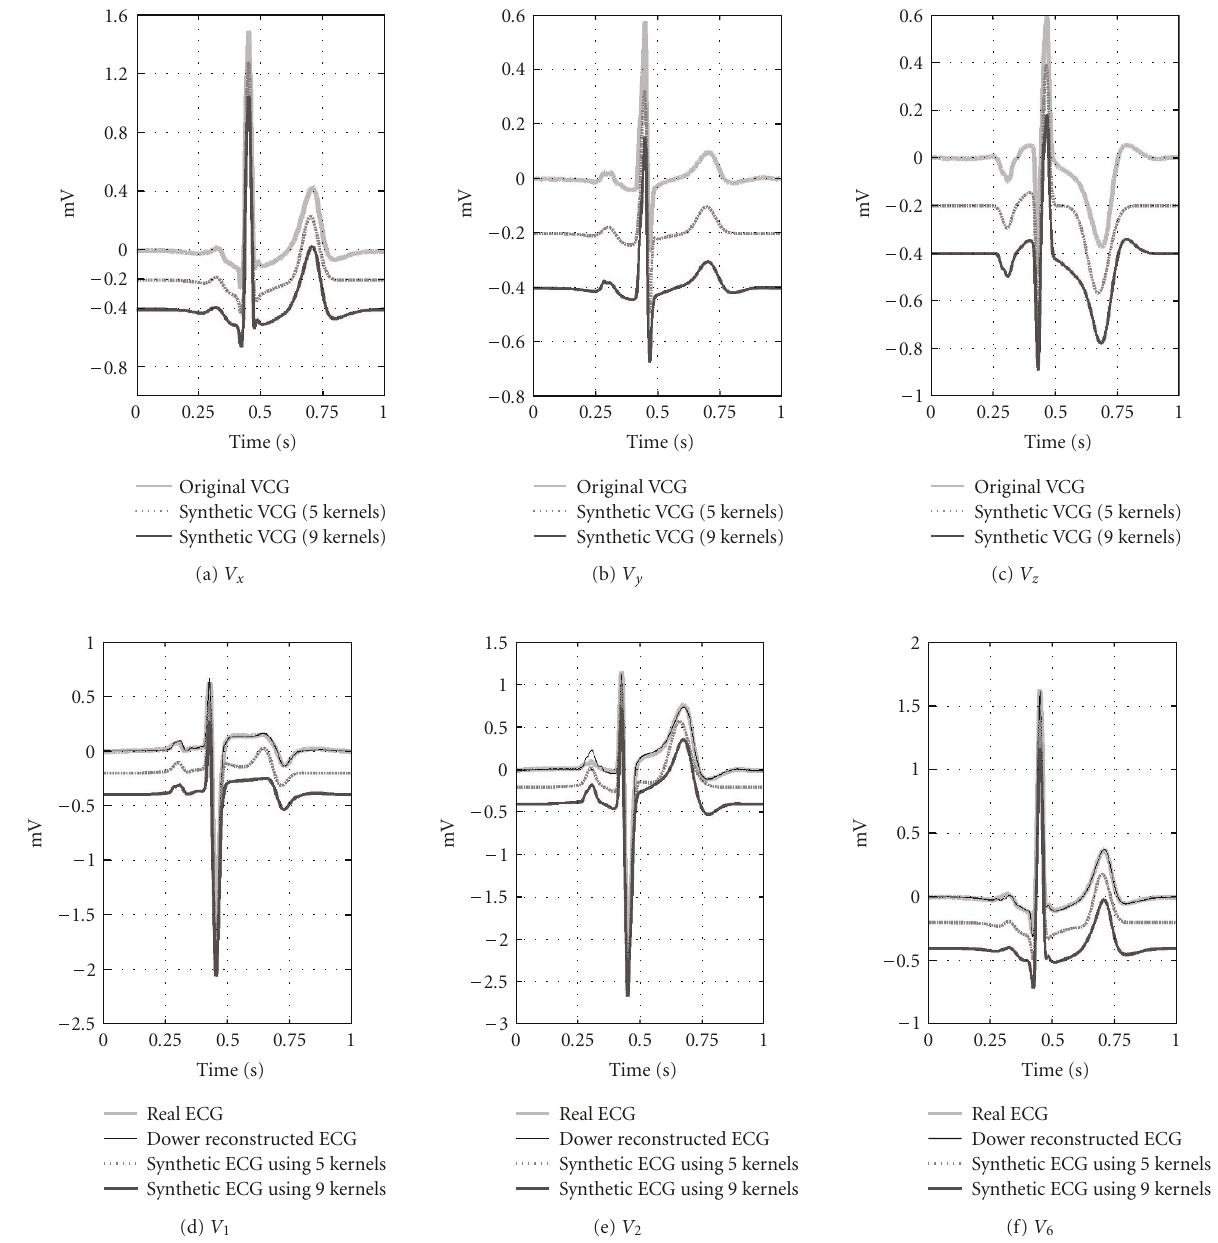
Figure 7: Original versus synthetic VCGs and ECGs using 5 and 9 Gaussian functions. For comparison, the ECG reconstructed from the Dower transformation is also depicted in (d)–(f) over the original ECGs. The synthetic VCGs and ECGs have been vertically shifted 0 . 2 mV for better comparison, refer to text for